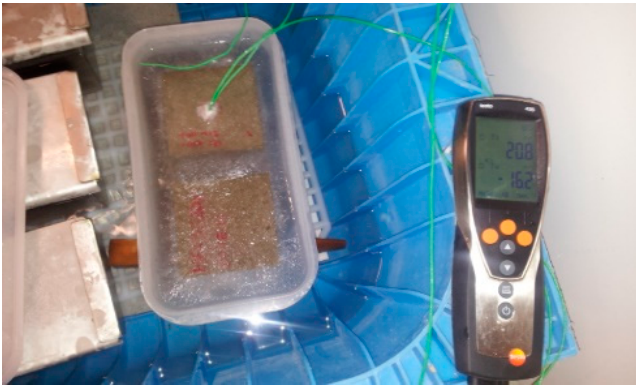
Figure 3. Freeze-thaw testing with temperature control.